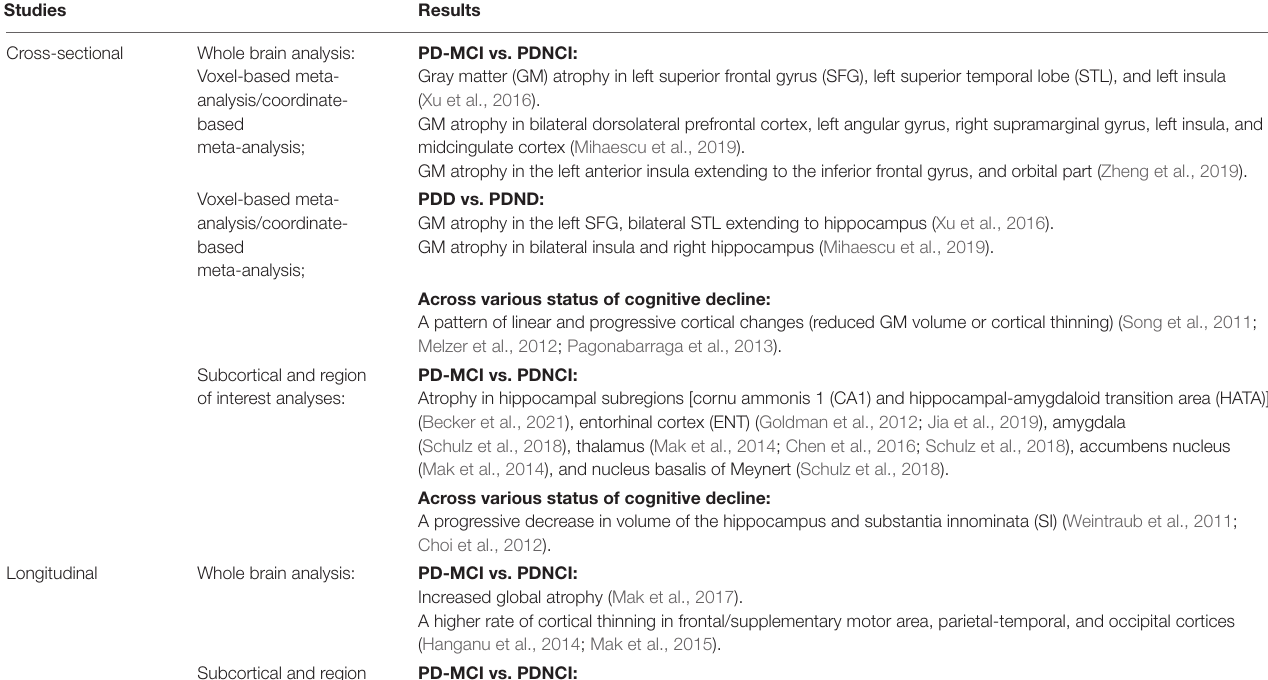
TABLE 2 | Summary findings from structural magnetic resonance imaging studies in Parkinson’s disease and cognitive impairment.